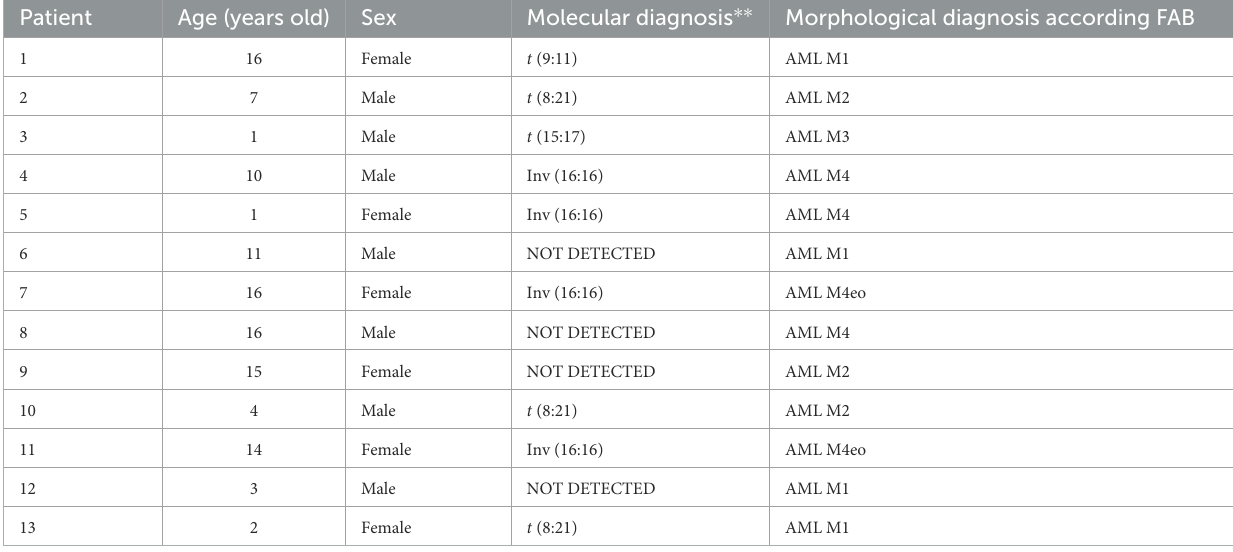
TABLE 1 Clinical characteristics in patients enrolled in this study.